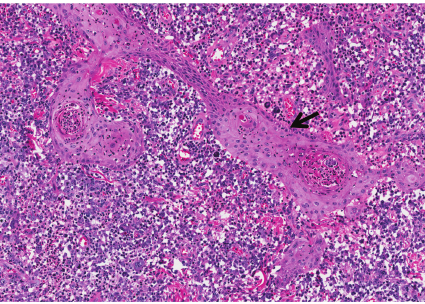
Figure 23: Spindle cell melanoma: medium-power magnification showing dermal pleomorphic spindle cell proliferation and focal junctional melanocytic nest (arrow). (H&E, × 100).